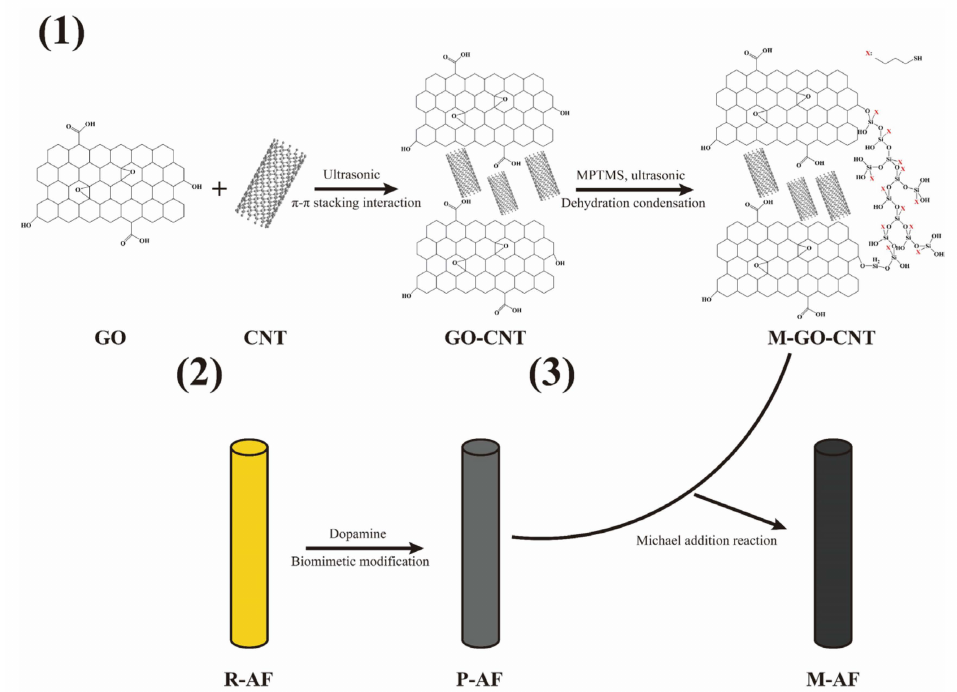
Figure 1. Schematic illustration of the surface modification of aramid